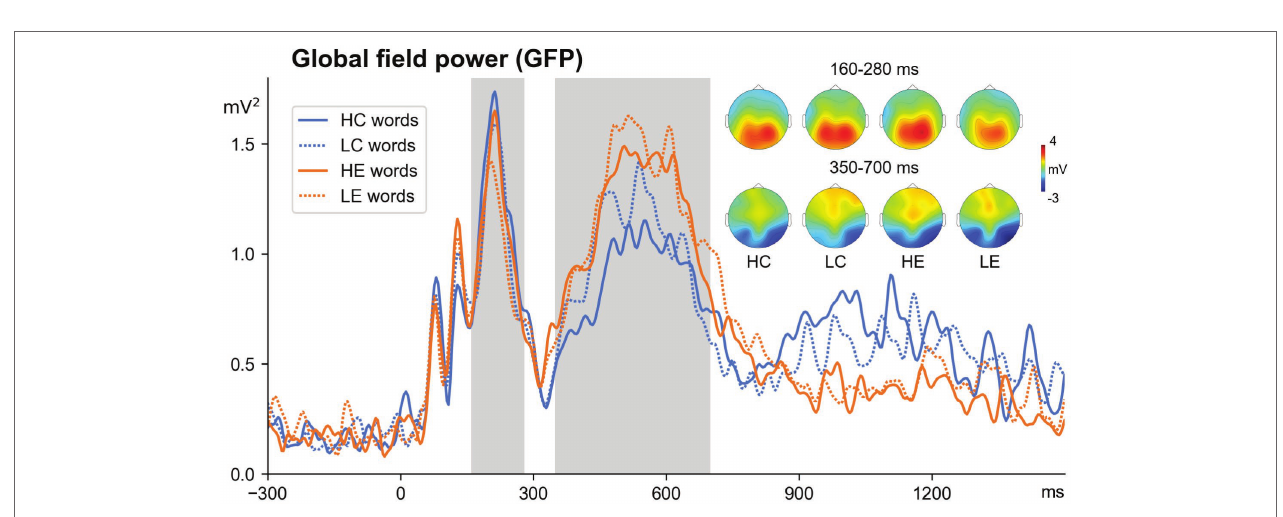
FIGURE 3 | Global field power (GFP, all electrodes) averaged across four experimental conditions and topographic